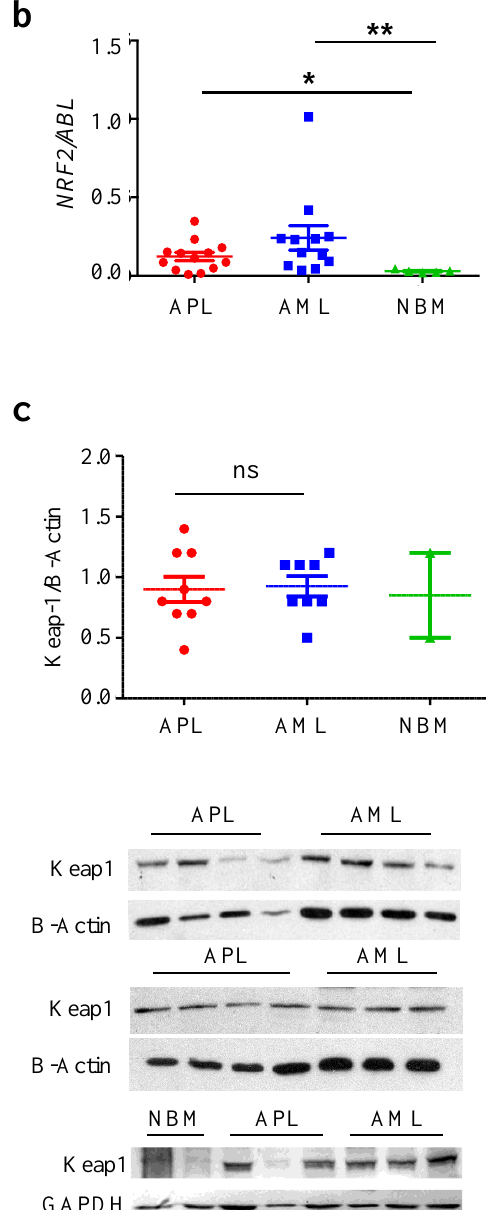
Figure 1. NF-E2 p45-related factor 2 (NRF2) protein level is lower in acute promyelocytic leukemia (APL) than in other acute myeloide leukemia (AML). ( a ) Western blot analysis of NRF2 in two samples from normal bone marrow (NBM), nine samples from APL patients and eight samples from AML patients. ( b ) Q-RT-PCR on NRF2 mRNA in 13 APL, 12 AML and five normal bone marrow (NBM) samples. ( c ) Western blot analysis of Keap1 in two samples from NBM, nine samples from APL patients and eight samples from AML patients. ns: non significative *: p ≤ 0.05; **: p ≤ 0.005 by Mann Withney test, not normal